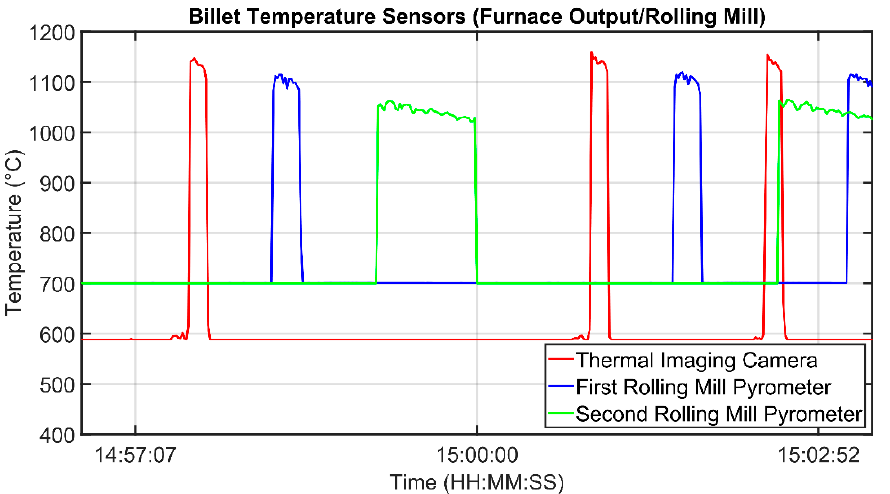
Figure 6. Billet temperature sensors measurements (furnace output/rolling mill).